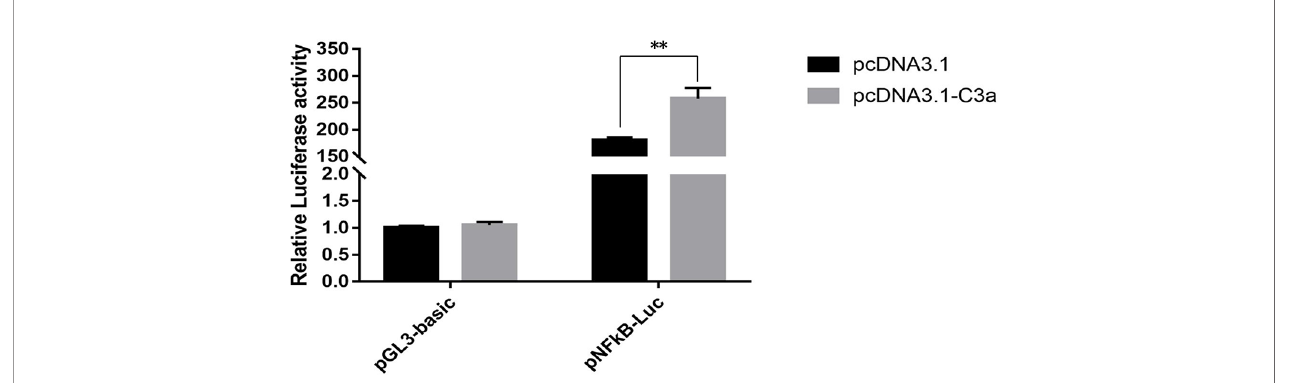
FIGURE 5 | Dual-luciferase reporter assays of pNF- k B activation in HEK293T transfected with pf-C3a . The bars indicated relative luciferase activity (n = 3). pcDNA3.1 and pGL3-Basic were used as the control. The amount relative to the internal control was expressed as mean ± S.D (n = 3). Signi fi cant differences across control were indicated (** P <